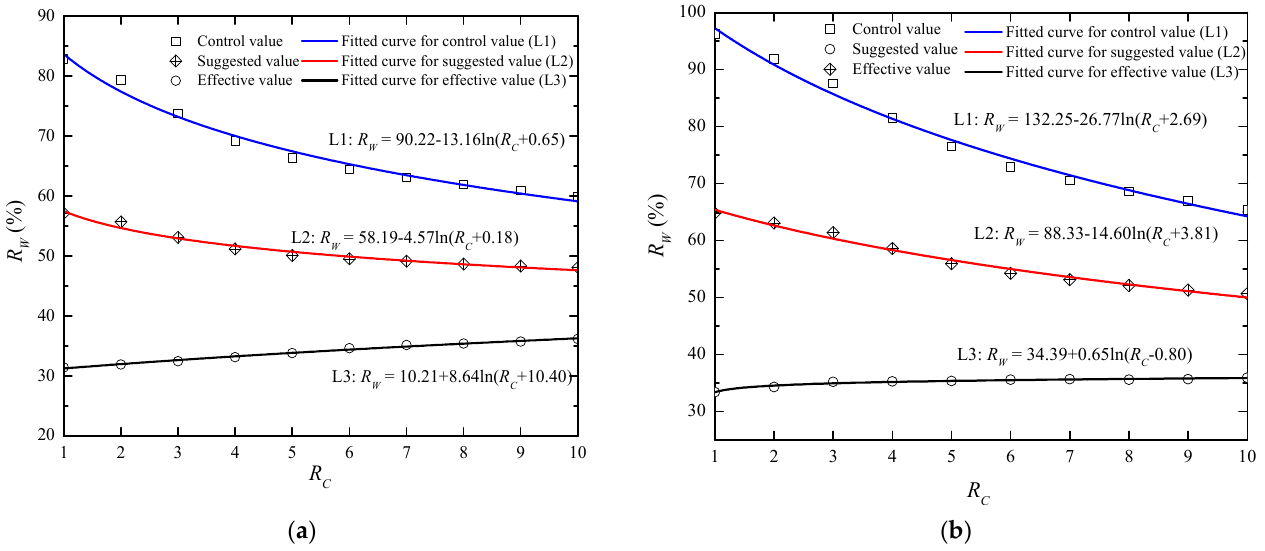
Figure 15. Relationship between control, suggested and effective R W and R C : ( a ) section I-I; ( b ) section II-II.